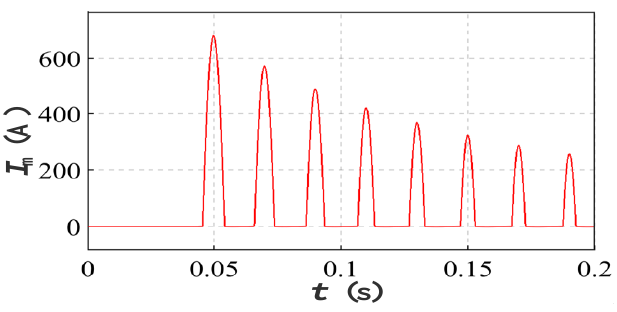
Figure 9. Influence of residual magnetism on overvoltage (WR is “with residual magnetization”, WNR is “without residual magnetization”).